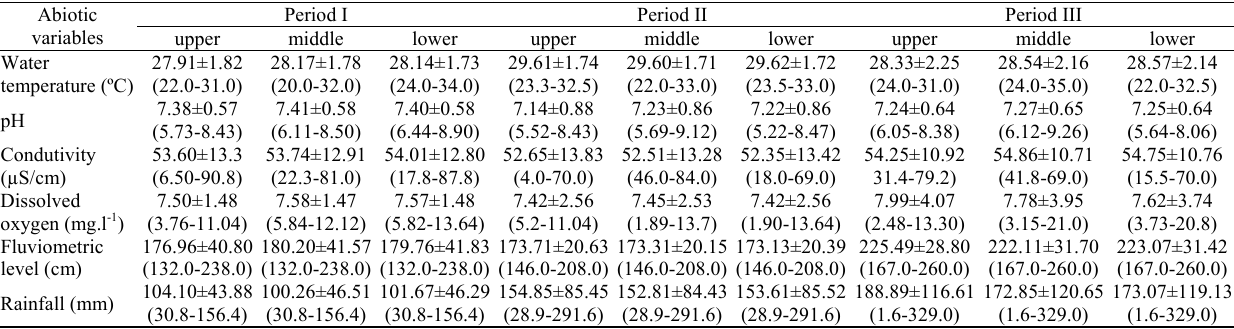
Table 1. Monthly average values and standard deviations (minimum and maximum) of abiotic variables during the study in the